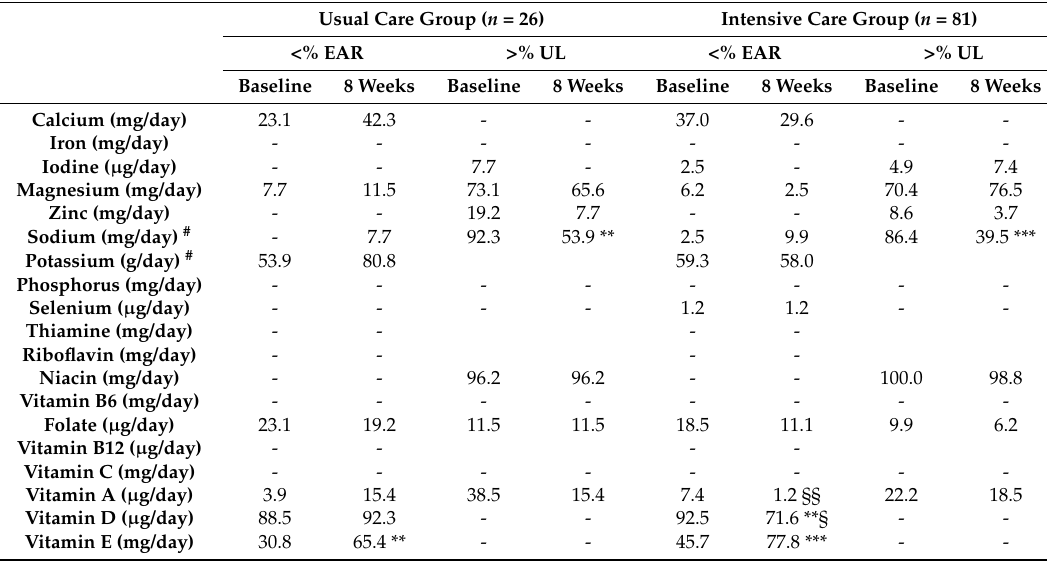
Table 4. Effect of lifestyle intervention on the proportion of individuals with inadequate intakes under the EAR/AI # or above UL by usual and intensive care